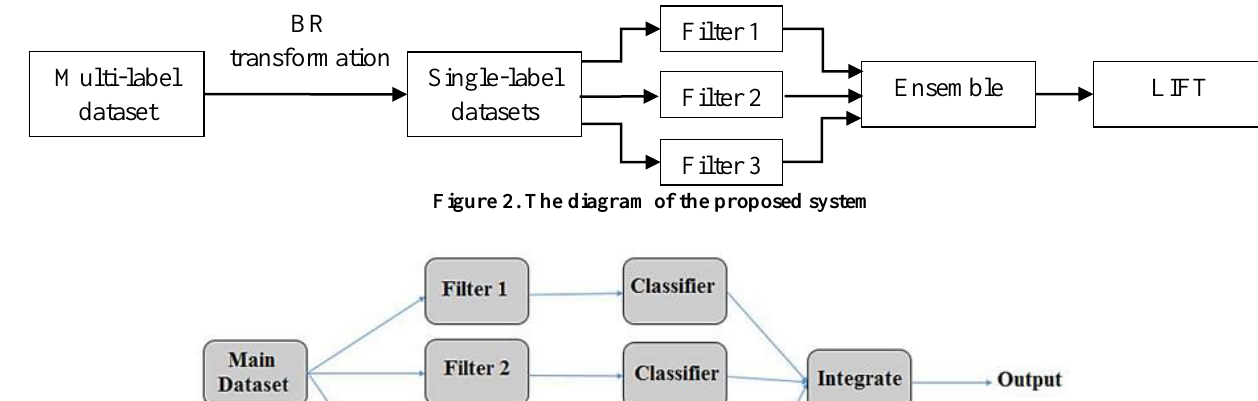
Figure 3. Model 1 of ensemble feature selection strategy [39].